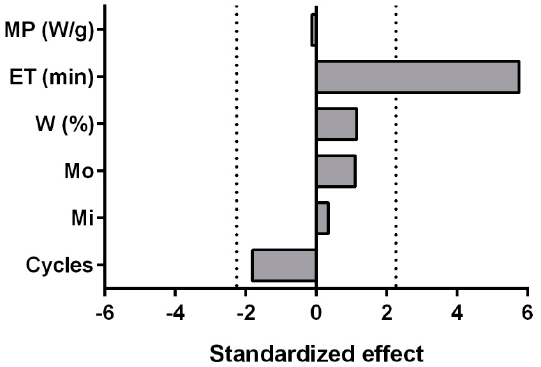
Figure 2. Pareto plots showing the factors that influenced the essential oil (EO) yield as determined in the fractional factorial design. The dot lines represent the statistically significant limits ( t -value α /2 of a t-distribution with degrees of freedom equal to the degrees of freedom for the error term) when the variables are reported in terms of standardized effect ( t -value of the coefficient). MP is the microwave power; ET is the extraction time; W is the percentage of water added to the seeds; Mo is the moistening process; Mi is the milling process.